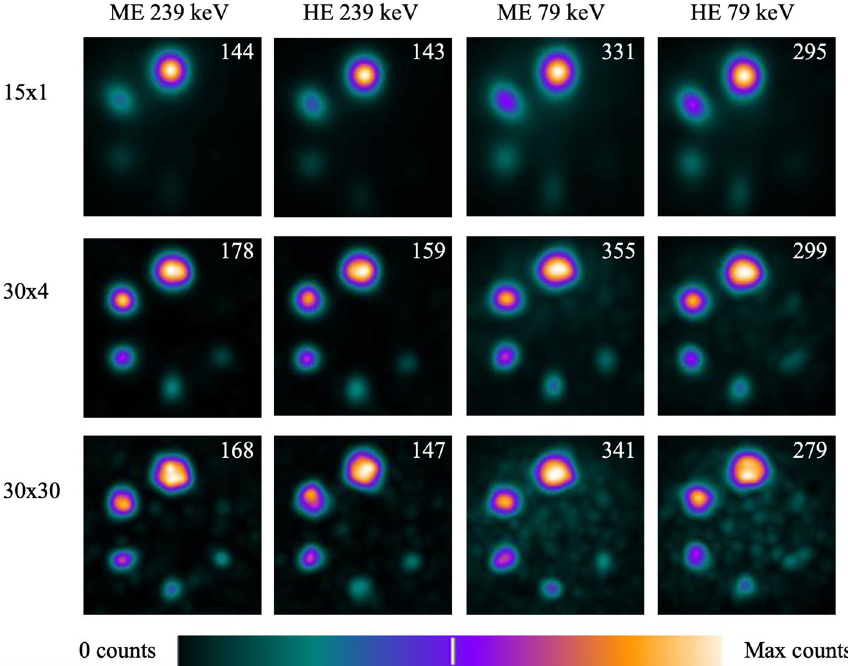
Fig. 7 Some of the filtered reconstructed images of the NEMA phantom filled with 88–100 kBq/ml 212 Pb for all the imaging protocols, but the maximum counts illustrated as white differs and is given in the top right corner of each image. Reconstructions 15 change with reconstruction